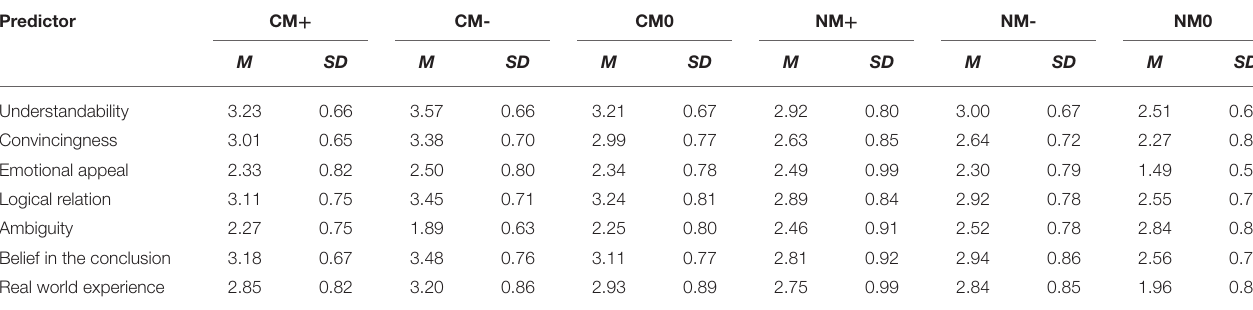
TABLE 5 | Mean (M) and standard deviation (SD) values of each predictor for each middle term condition (Experiment 1). Predictor